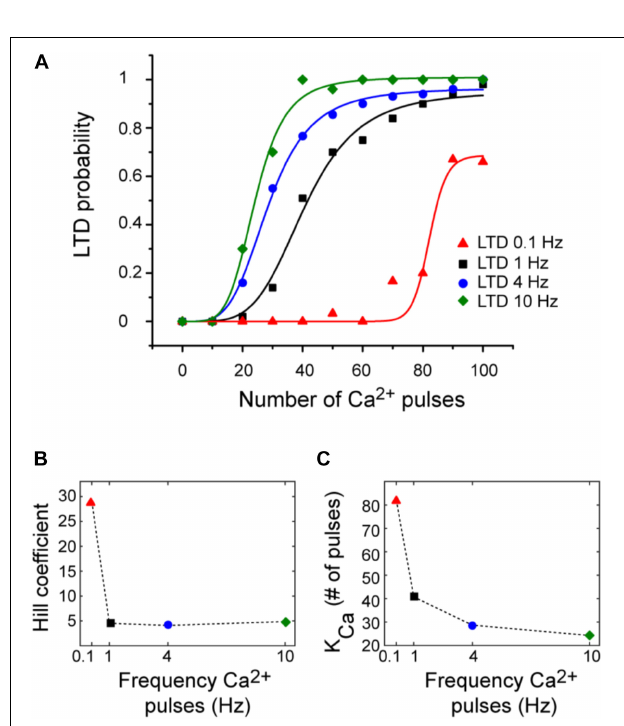
FIGURE 5 | LTD probability over number of Ca 2 + pulses at 0.1, 1, 4, and 10 Hz. (A) Relationship between number of Ca 2 + pulses and LTD for different frequencies of 0.1 Hz (red), 1 Hz (black), 4 Hz (blue), and 10 Hz (green). Every symbol represents the probability to get LTD state at specific number of Ca 2 + pulses and frequency over 100 trials. Smooth curves represent fits of the Hill equation. (B) nHill coefficient at the four different frequencies and (C) K Ca